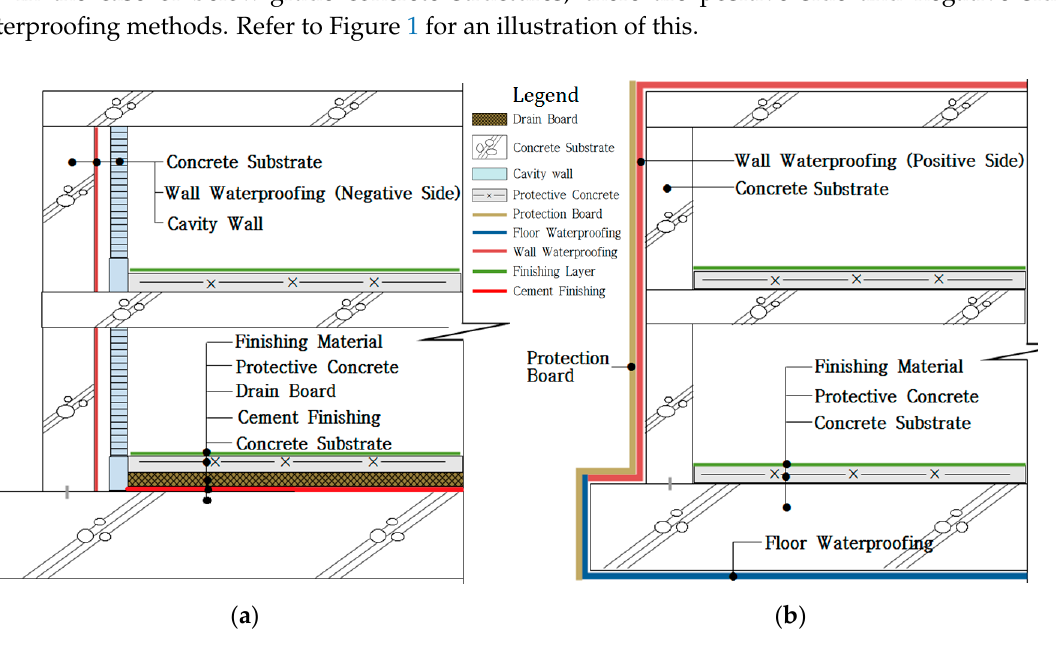
Figure 1. Comparison of positive and negative side waterproofing methods; ( a ) negative side waterproofing; ( b ) positive side waterproofing.